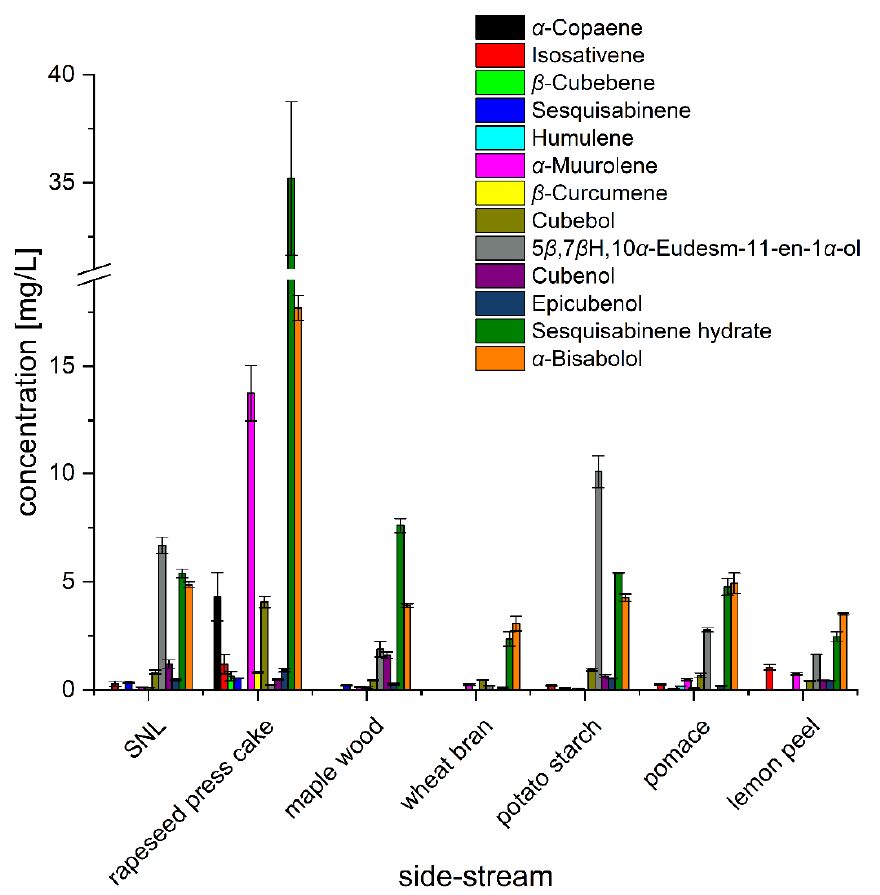
Figure 3. Sesquiterpenoid production during the submerged cultivation of Cerrena unicolor for eleven days, supplemented with side ‐ streams from the food and agro ‐